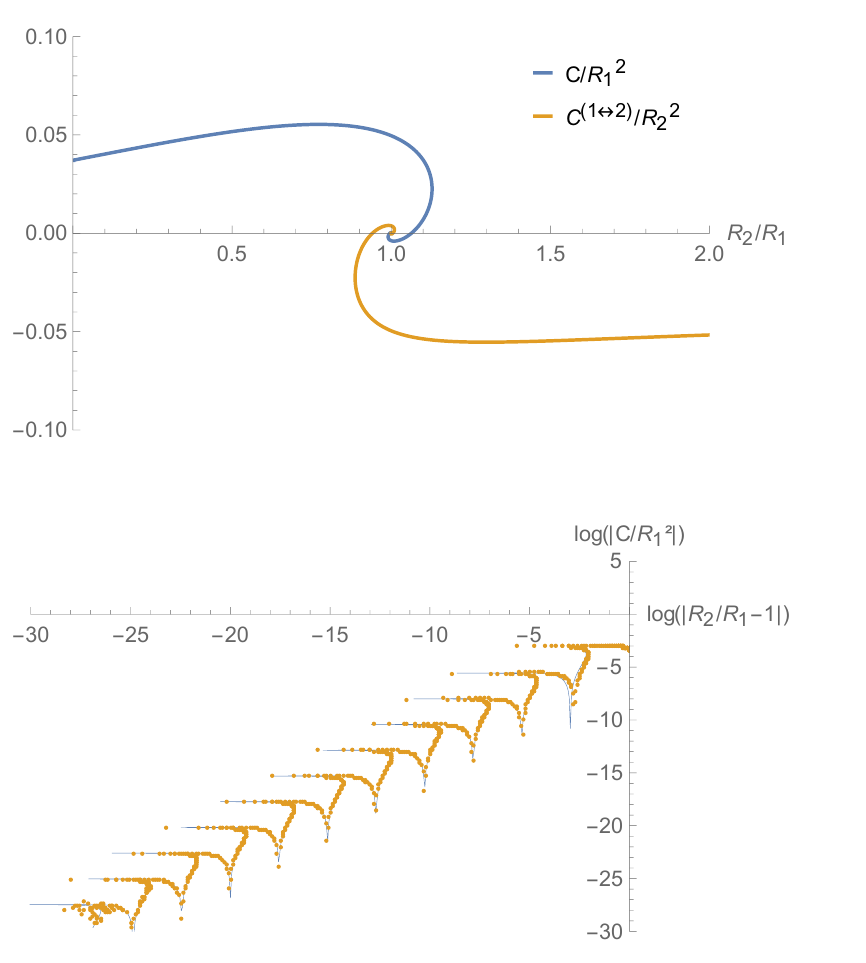
Figure 7 . Top: C= R 2 in both the case where the sphere 1 shrinks (blue) and the case where the 1 sphere 2 shrinks (orange). Bottom: the same plot in the case where sphere 1 shrinks, where we represent the logarithm of the distance to the center of the spiral with coordinates (1 ; 0) for each quantity. The orange dots are given by numerical computation while the blue curve is the (cid:12)t found in (7.19)-